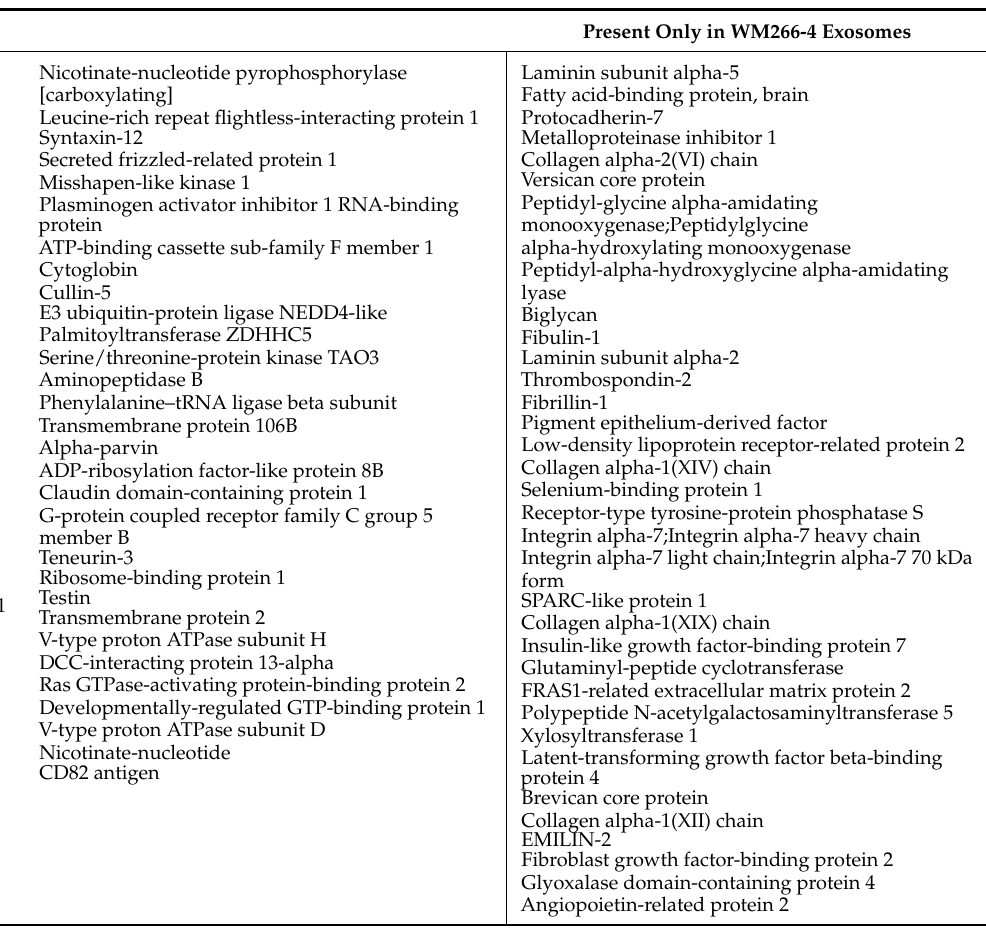
Table 4. List of proteins identified in WM115-derived exosomes but not found in any replicates of WM266-4-derived exosomes and vice